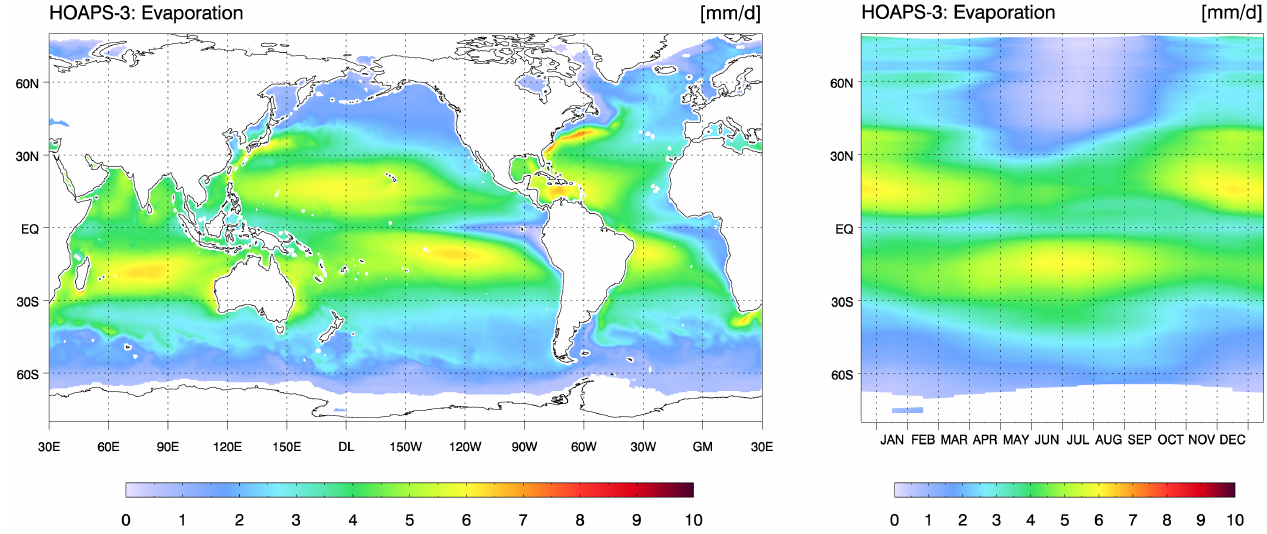
Figure 14. Climatological mean field (left) and zonal mean annual cycle (right) of HOAPS-3 evaporation for the years 1988 to 2005.